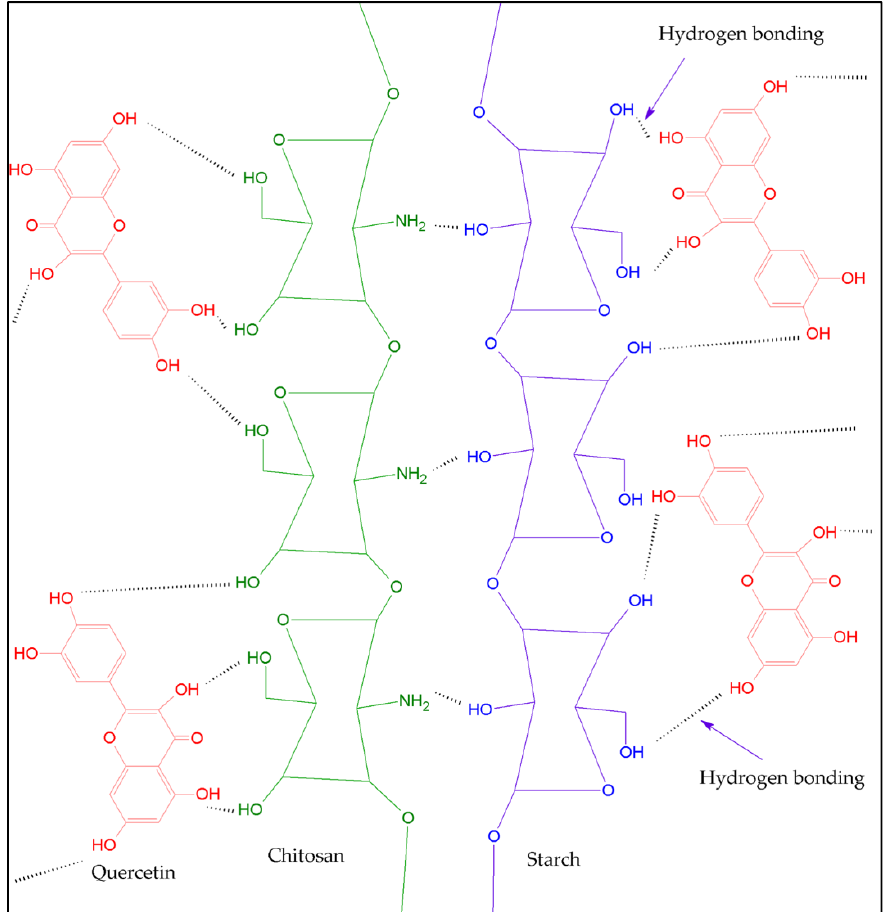
Figure 3. Scheme of hydrogen bonding interaction between chitosan (green structure), starch (blue structure), and quercetin (molecule in red color).